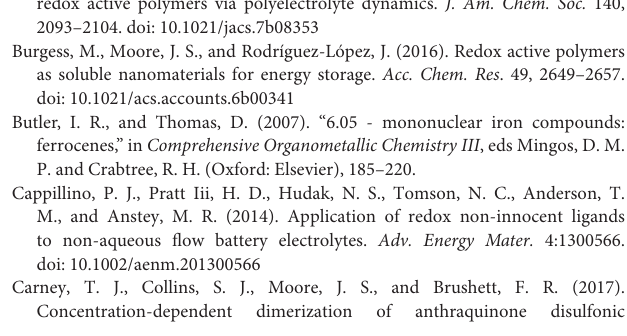
species (represented by metal ions), organic redox molecules, which can have inherent features such as flexible design, stable, easily tailored electrochemical properties, and cost-effectiveness, are more promising for RFBs targeted toward residential and industrial